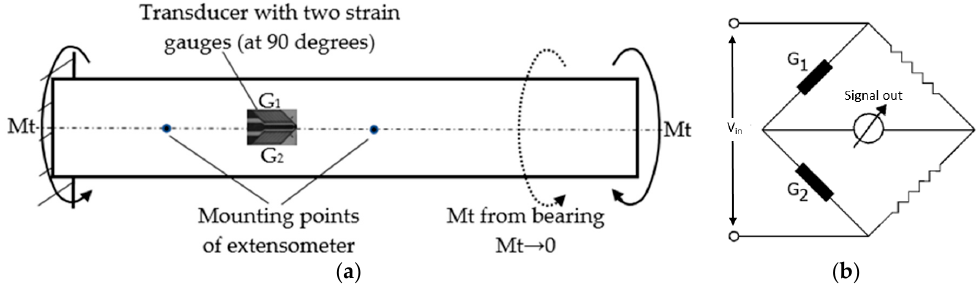
Figure 7. Measuring torsion strain using tensiometric transducers (two strain gauges): ( a ) mounting strain gauges on the control sample; ( b ) linking strain gauges in a half-bridge Wheatstone.